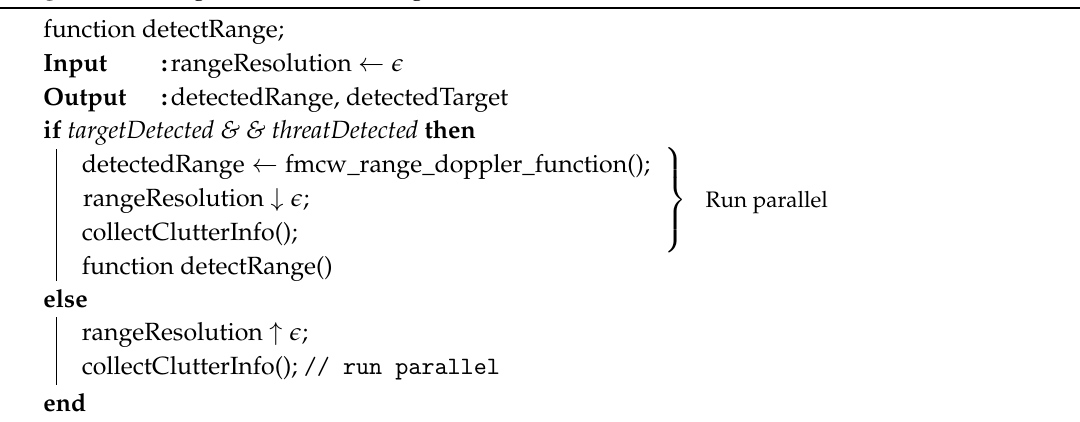
Algorithm 2: Algorithm for semi-cognition and